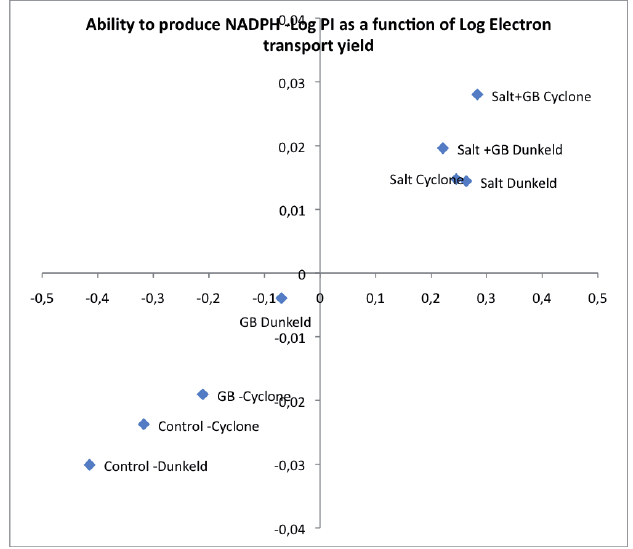
Fig. 7: Ability to produce NADPH of two cultivars of canola ( Brassica napus L.) when three week old plants were subjected to foliar application of glycinebetaine and salt stress for further two